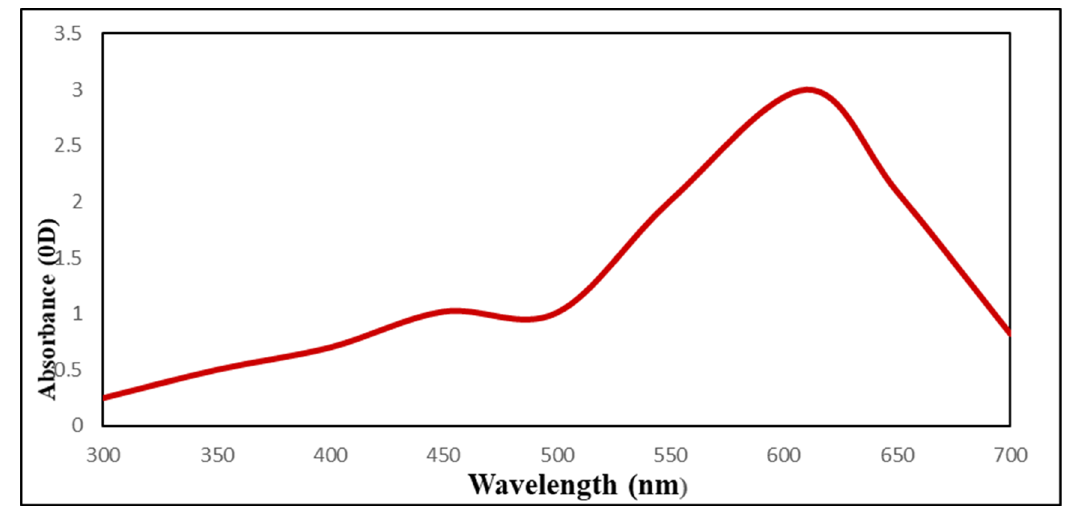
Figure 3. The UV-Visible spectrum of Ulva lactuca mediated selenium nanoparticles. Figure 3. The UV‑Visible spectrum of Ulva lactuca mediated selenium nanoparticles.